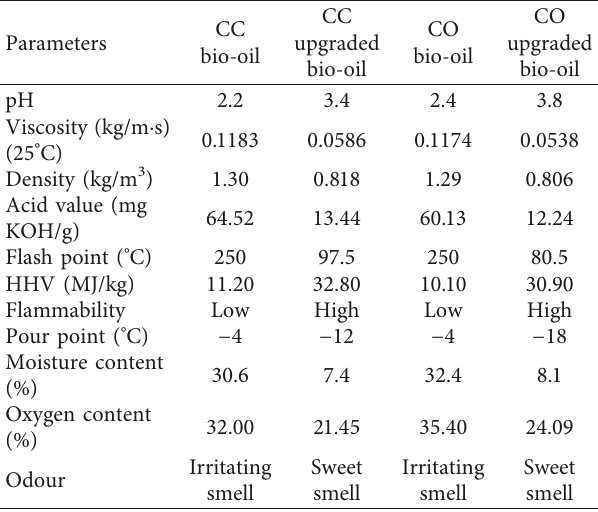
Figure 2: XRD patterns of the raw and acid-modified biochar. Table 4: Properties of raw and upgraded bio-oil derived from CC and